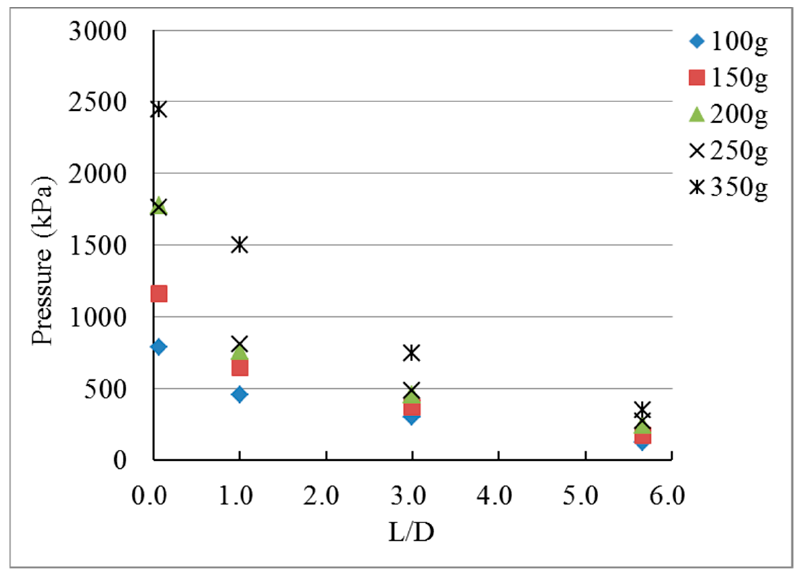
Figure 7. Comparison diagram of explosion experiment results of linear tunnel with single-pressure relief orifice plate.